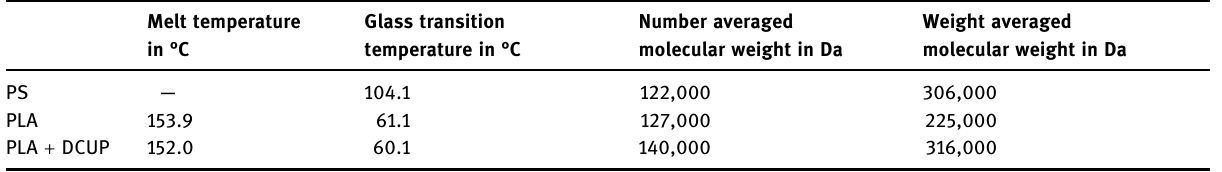
Table 1: Overview of melt temperature ( T m ) , glass transition temperature ( T g ) , number averaged molecular weight ( M n ) , and weight averaged molecular weight ( M w ) of PS, PLA, and PLA +